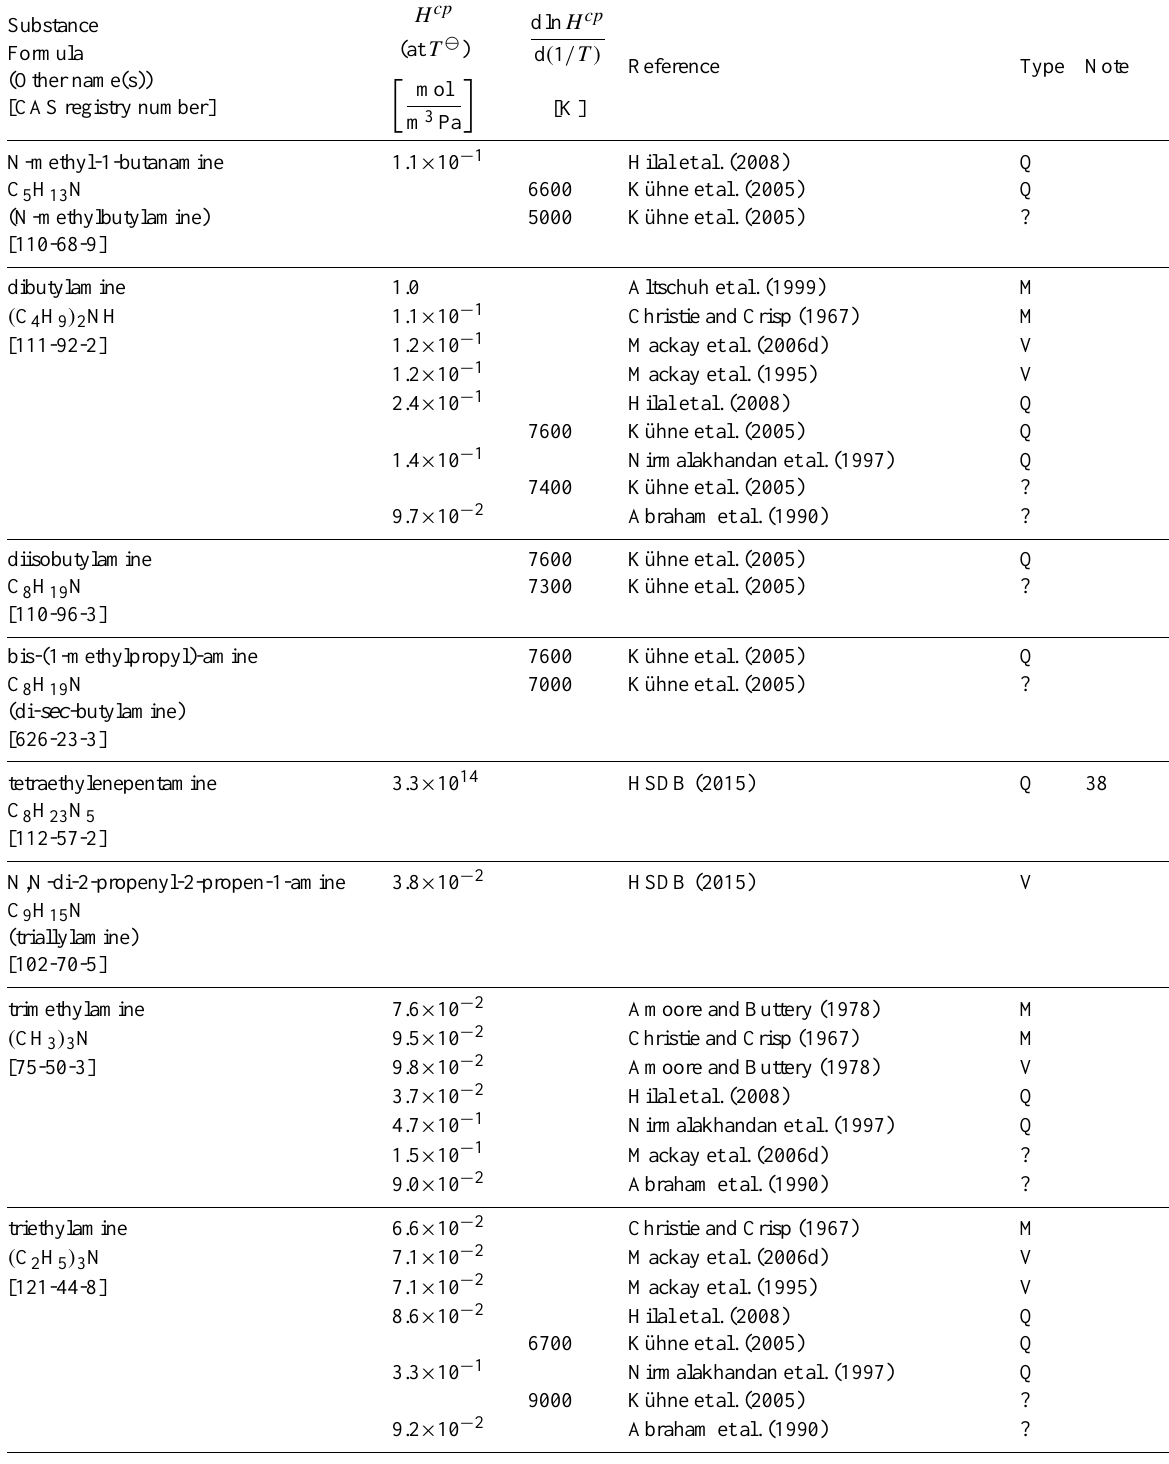
Table 6: Henry’s law constants for water as solvent